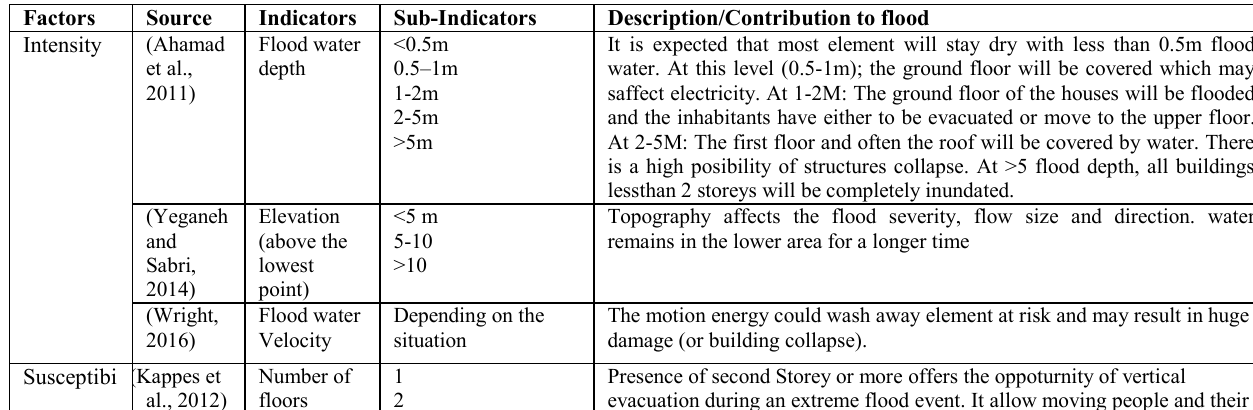
Table 2: Residential building vulnerability